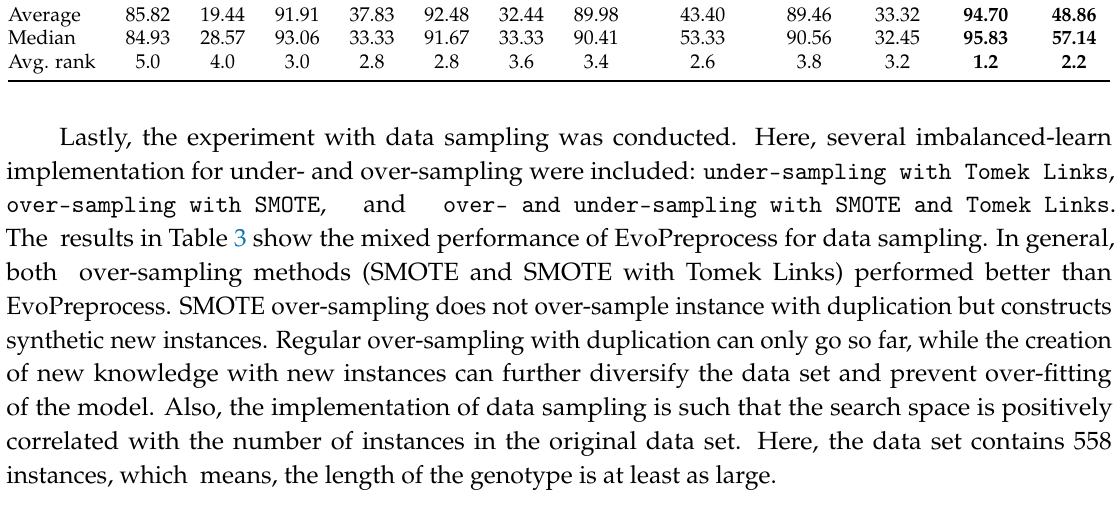
Table 3. Accuracy and F-score results of data sampling (under- and over- sampling). The best values are bolded. Under-Sampling Over-Sampling Over-under- Sampling CART Tomek Links SMOTE SMOTE with Tomek